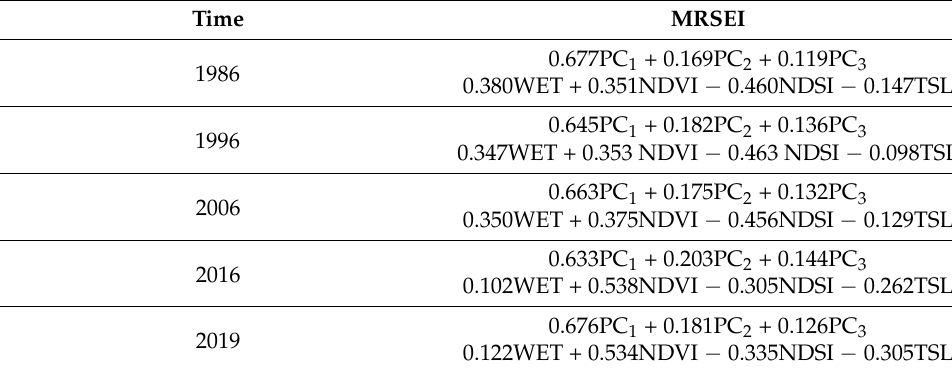
Figure 4. Principal component analysis of the MRSEI. Table 4. The finalized formula of the MRSEI.